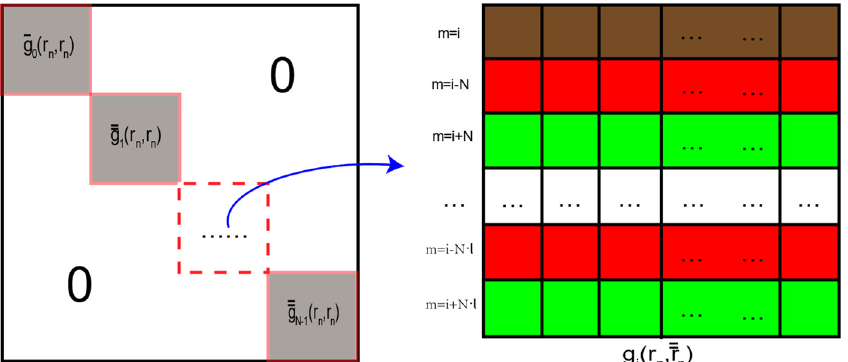
Figure 5. The layout of the matrix element of g-matrix. It is rearranged as a block diagonal matrix with N blocks referring to the structure of the U matrix. Different colors correspond to different azimuth mode “ m ”, brown indicates m = i , red and green indicate increase and decrease on this basis